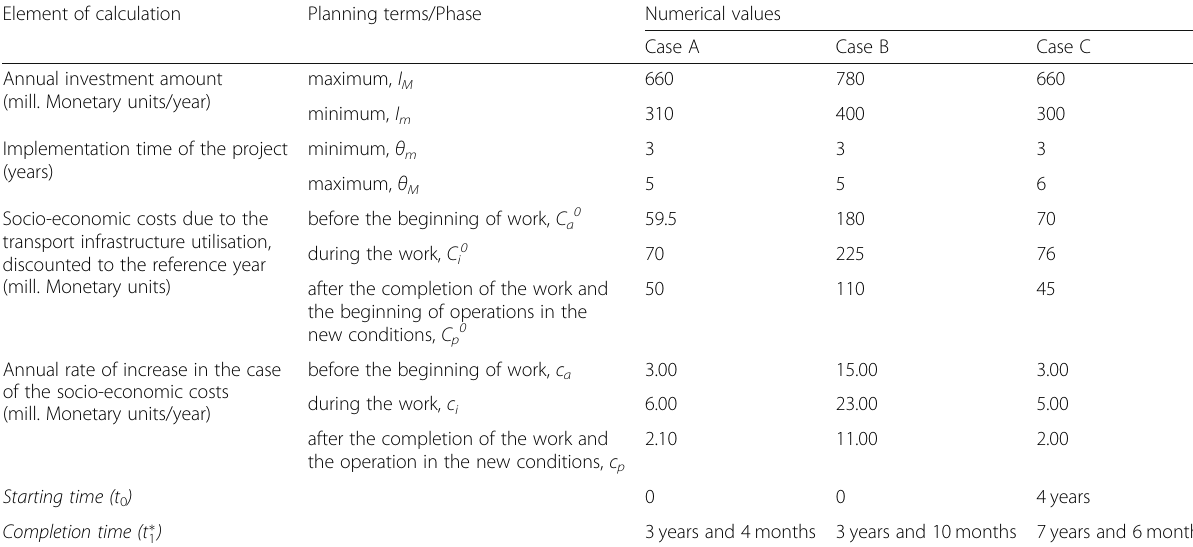
Table 1 Determining of the optimal time of project implementation Element of